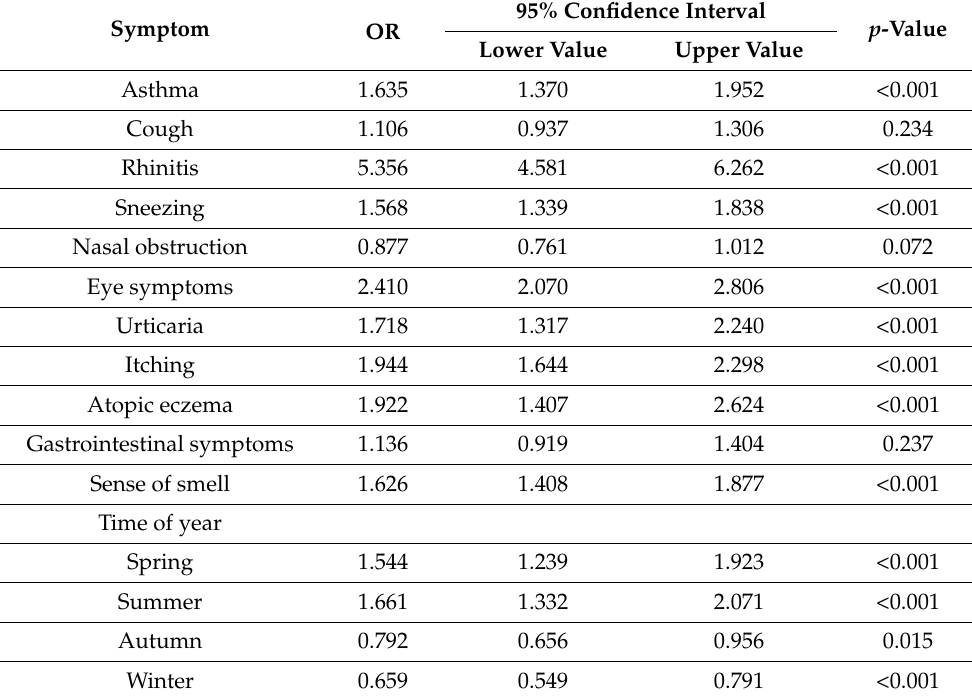
Figure 4. Overall concordance of SPT (intradermal test for mold) and specific serum IgE. When looking at specific symptoms reported by patients sensitized to spring bloomers, data on 3815 subjects could be evaluated. The probability of rhinorrhea was highest, followed by other symptoms such as asthma, atopic eczema, sense of smell and urticaria. Nasal obstruction and coughing did not have a significantly higher probability in subjects sensitized to spring bloomers, as compared to nonsensitized subjects (Figure 5a, Table